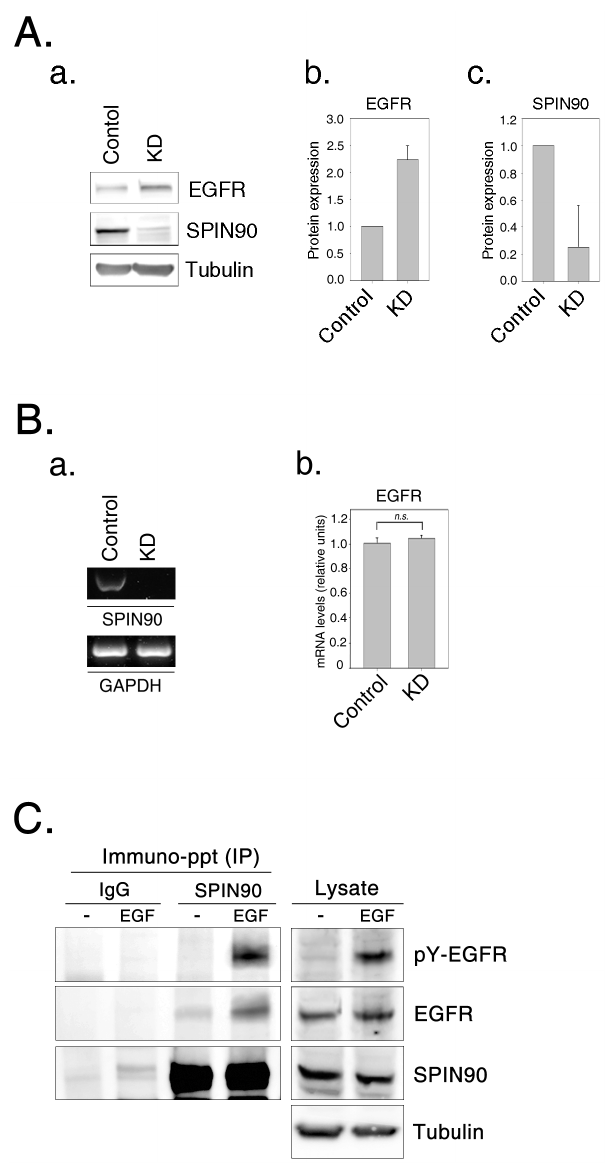
Figure 1. SPIN90 is a specific regulator of EGFR endocytosis. A. (a) Whole-cell lysates of control and SPIN90 knockdown (KD) HeLa cells were separated using SDS-PAGE, and immunoblotted with polyclonal anti-EGFR antibody to quantify the total amounts of EGFR. The experiment was repeated more than three times. Levels of EGFR (b) and SPIN90 (c) were quantified via densitometry using MultiGauge software. B. The relative abundance of SPIN90 (a) and EGFR mRNA (b) was quantified in control and SPIN90 knockdown (KD) HeLa cells using RT-PCR (a) or qPCR (b). Values of qPCR for EGFR transcripts were normalized with those for GAPDH transcripts. C. Identification of the SPIN90 interaction with EGFR. Cells were subject to starvation for 16 h then treated with EGF (40 ng/ml) for 10 min. Cell lysate were immunoprecipitated with rabbit anti-IgG or rabbit anti-SPIN90 anti- bodies and blotted with rabbit anti-pY-EGFR